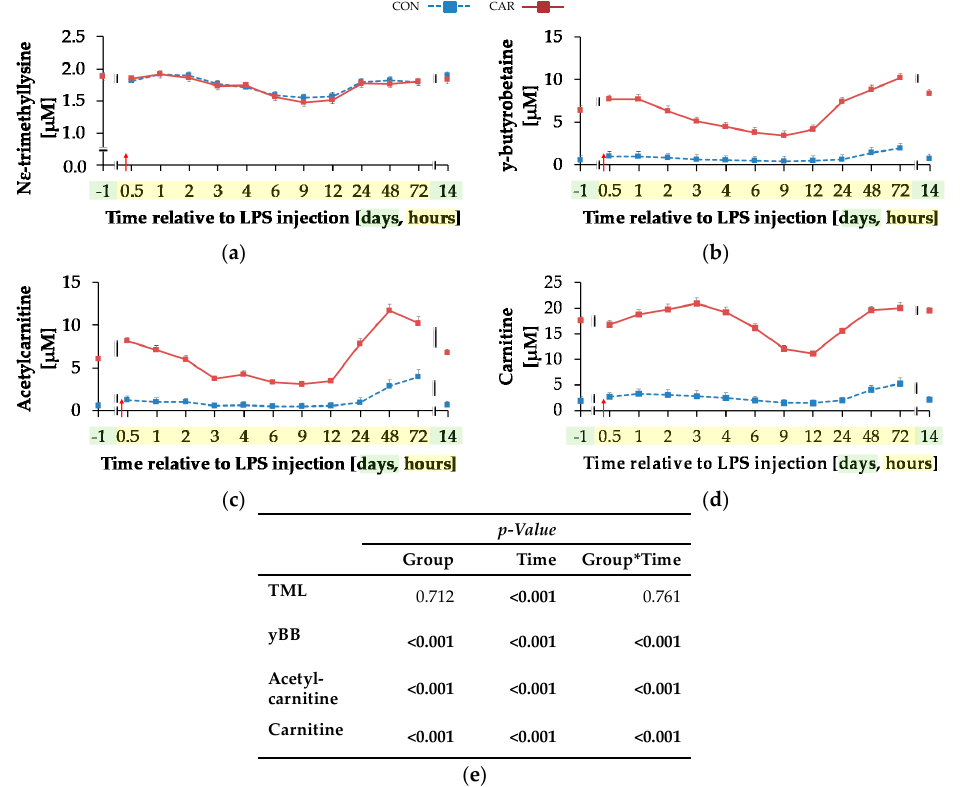
Figure 5. Progression of carnitine metabolites in plasma of dairy cows fed a non-supplemented (CON) or an L-carnitine supplemented diet (CAR, 25 g/d from 6 weeks ap up to day 126 pp) before and after an intravenous injection of 0.5 μ g/kg BW lipopolysaccharides (LPS) on day 111 pp (red arrow). ( a ) Concentration of N Ƹ –tri-methyl-lysine (TML), ( b ) y-butyro- betaine (yBB), ( c ) acetyl-carnitine; ( d ) free carnitine. ( e ) Data statistics. Data are given as LS-Means standard errors. Signif- icant p -values are marked as bold.